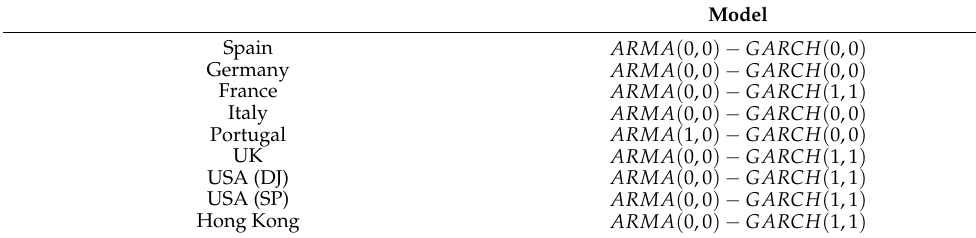
Table A2. Filter models.